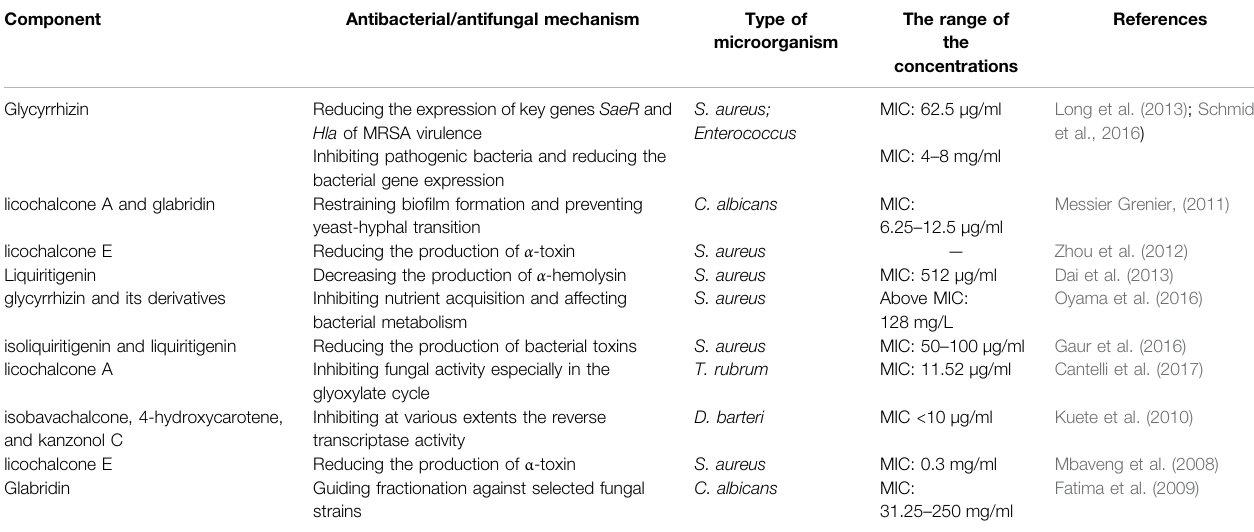
TABLE 3 | Antibacterial and antifungal mechanism of